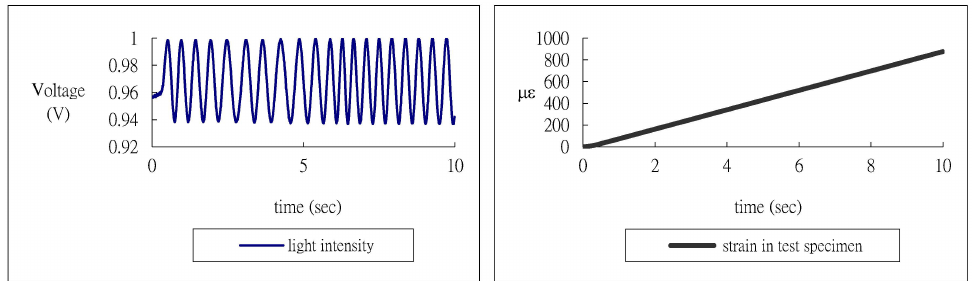
Figure 6. Light intensity of Mach-Zehnder interferometer and strain of test specimen measured by strain gauge for M-coat adhesive with bonding length 60 mm.